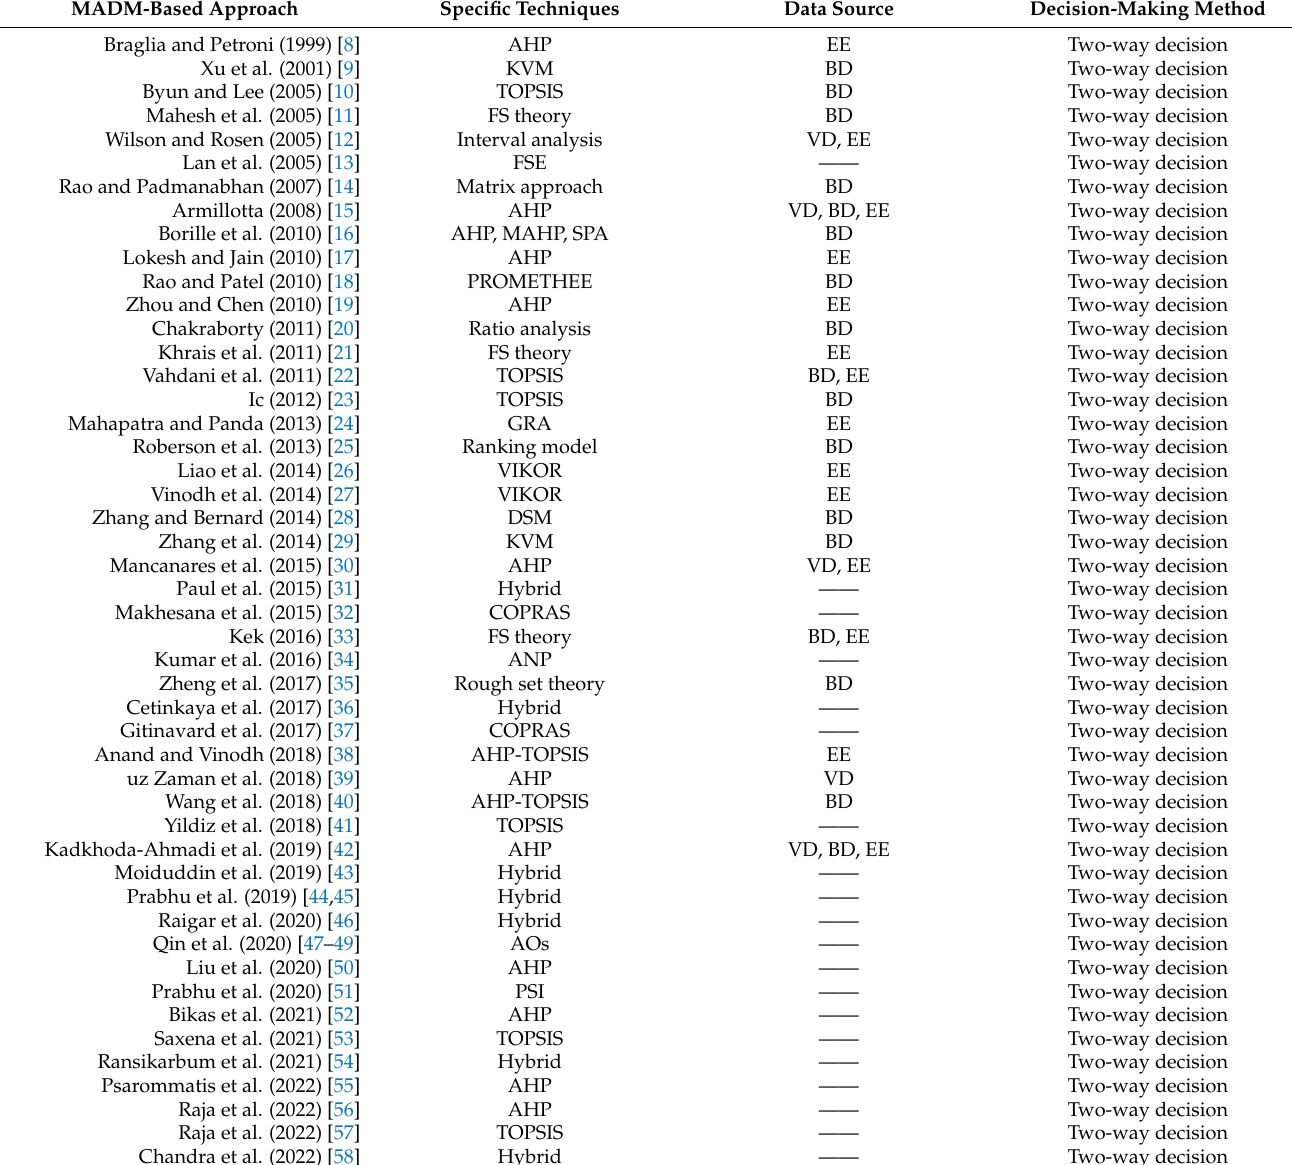
Table 1. An overview of the forty-eight MADM-based approaches in the